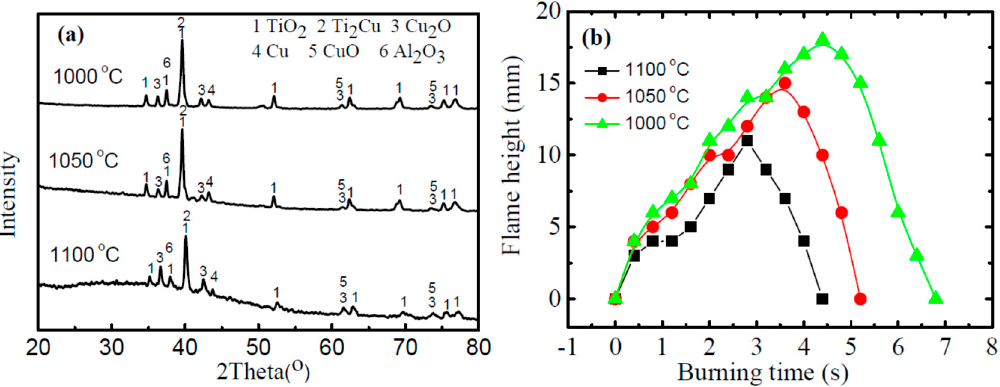
Figure 8. ( a ) XRD results of the burned products of forged Ti14 alloys ( C o = 20%); and ( b ) comparisons of the flame height as a function of the burning time for the Ti14 alloy obtained from different forging temperatures ( C o = 20%). The flame height was estimated from the recorded images every 0.4 s.